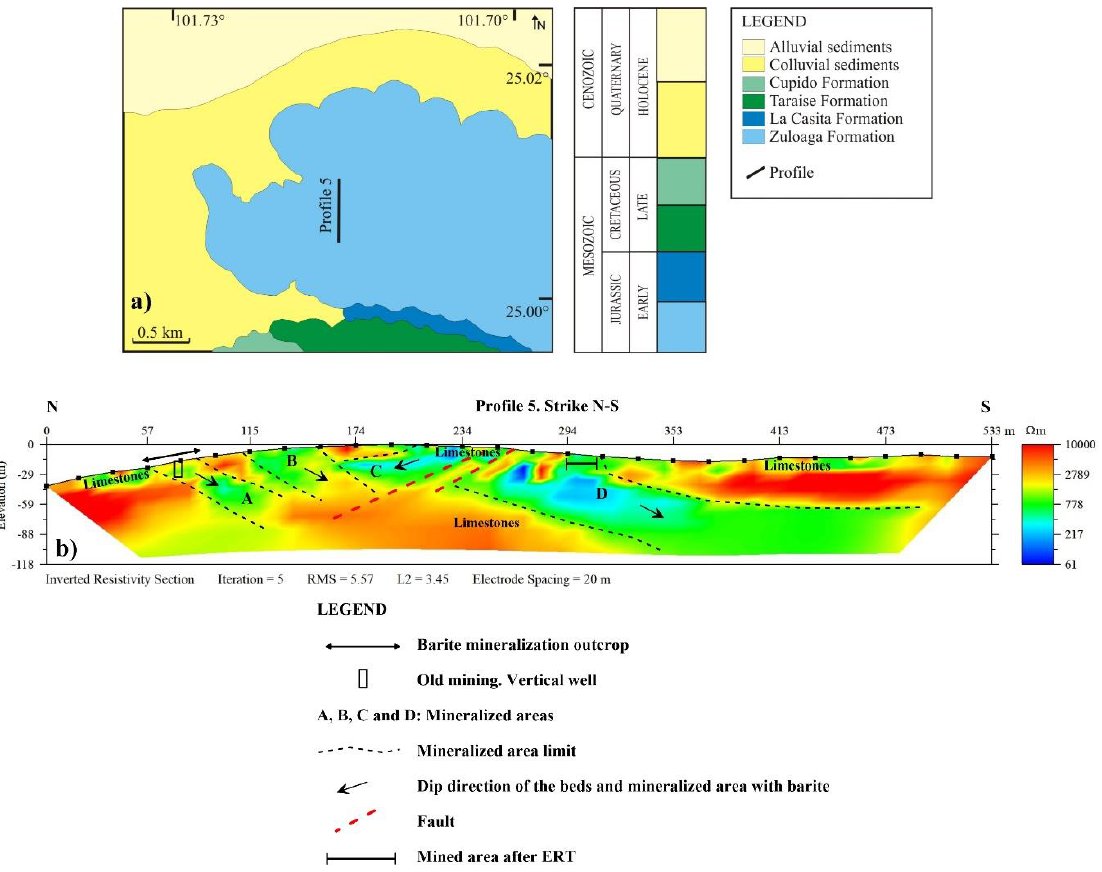
Figure 9. ( a ) Geological map of the El Tapón mine. Modified from Santiago-Carrasco and Maciel-Hernández [18]. ( b ) Inverted resistivity section. ERT in the MVT-type barite deposit. The stratigraphic column is not to scale.